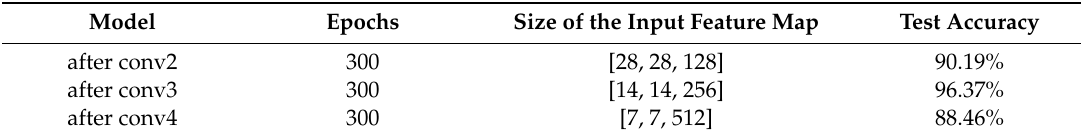
Table 5. Comparison of the ASPP module at di ff erent